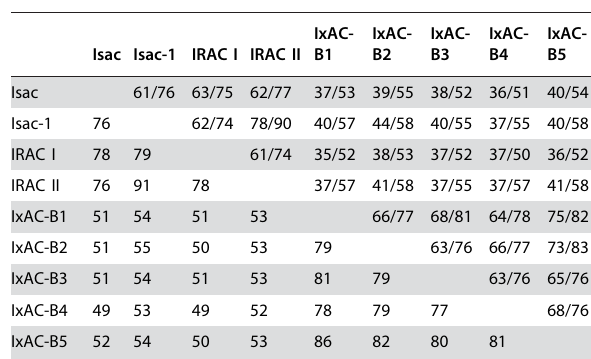
Percent identity/similarity of amino acid sequences are indicated in the upper right triangle. Percent identities of nucleotide sequences are indicated in the lower left triangle.